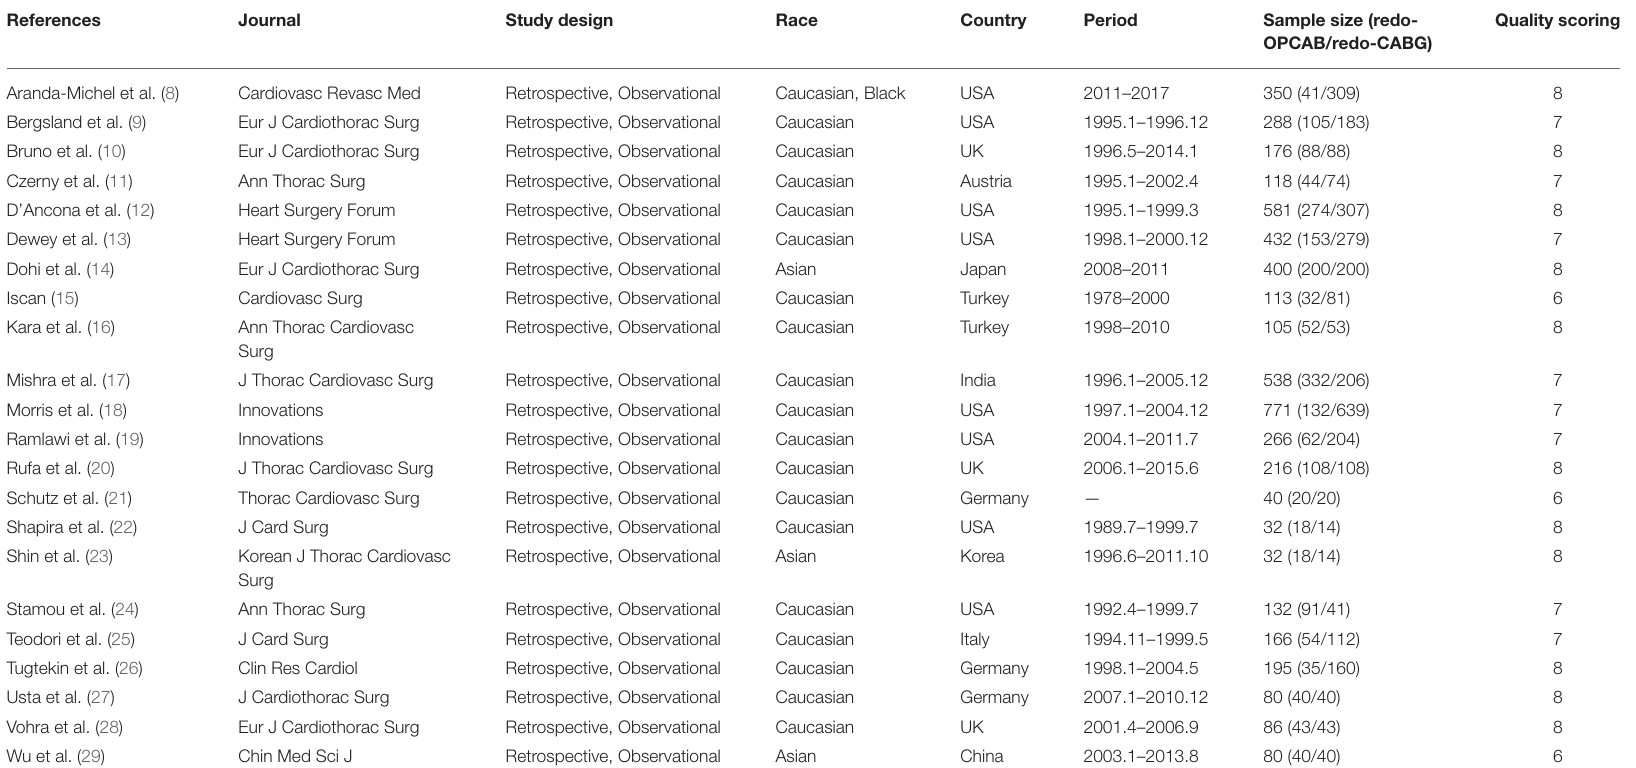
TABLE 2 | Studies included in the meta-analysis and quality